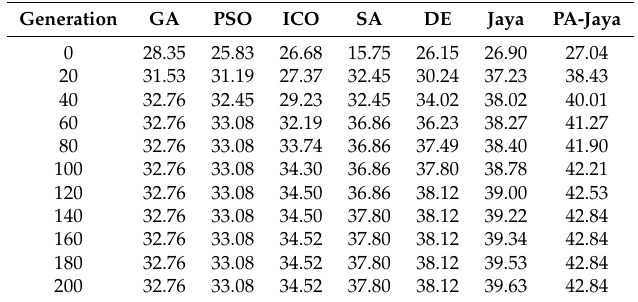
Table 3. Optimal solutions of the total system transmission rate during